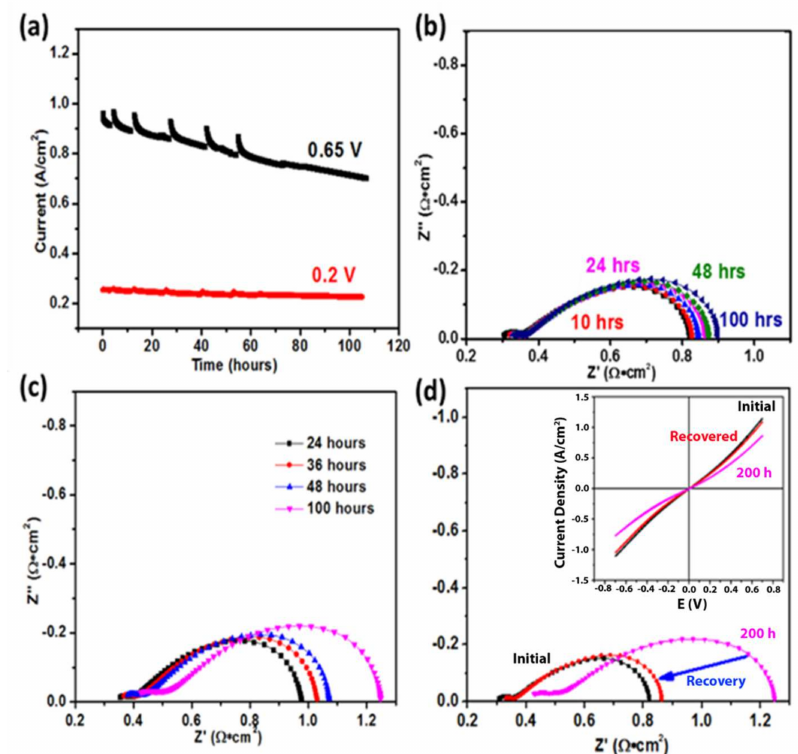
Figure 4. ( a ) Current passed through symmetrical LCFCr/GDC/LCFCr cell at 800 ◦ C in air at a cell voltage of 0.65 V for 100 h in comparison with 100 h at a cell voltage of 0.2 V in a 2-electrode symmetrical-cell configuration. OCP Nyquist plots after 3, 10, 24, 36, 48, and 100 h of polarization at cell voltages of ( b ) 0.2 V and ( c ) 0.65 V, and ( d ) Nyquist and CV (inset) plots after 10 h at the OCP, showing almost complete cell